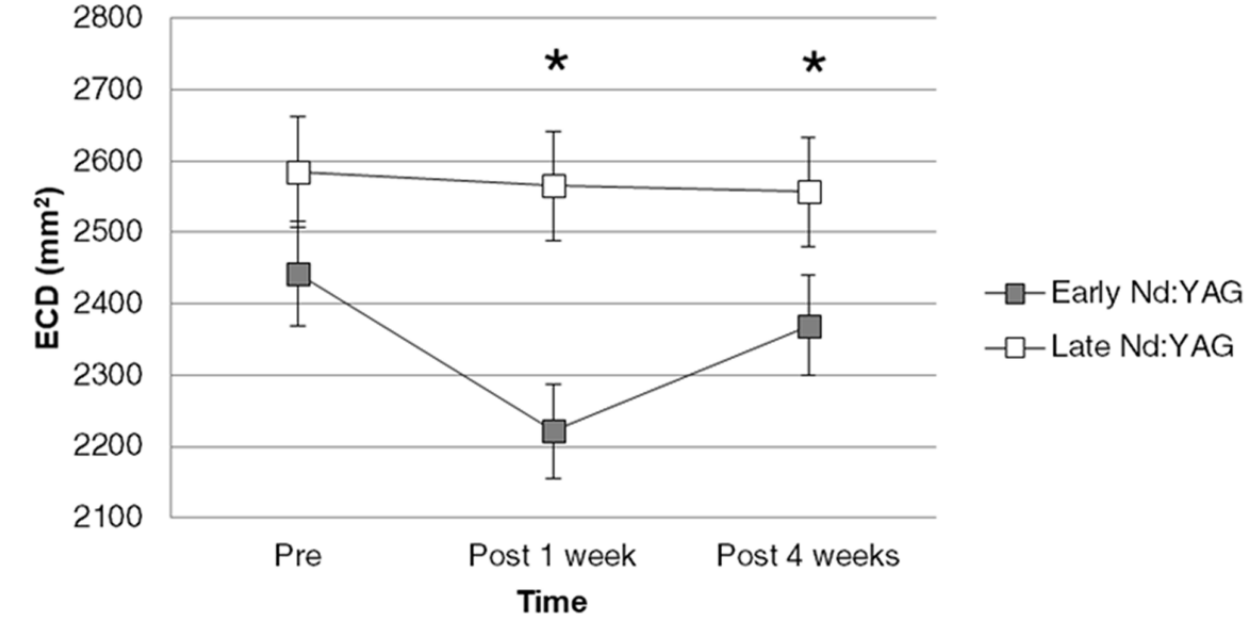
Figure 1. The ECD at different time points after early (<12 months) or late ( ≥ 12 months) Nd:YAG laser capsulotomy. Nd:YAG: neodymium:yttrium–aluminum–garnet; ECD: endothelial cell density; * denotes significant difference between the two groups.